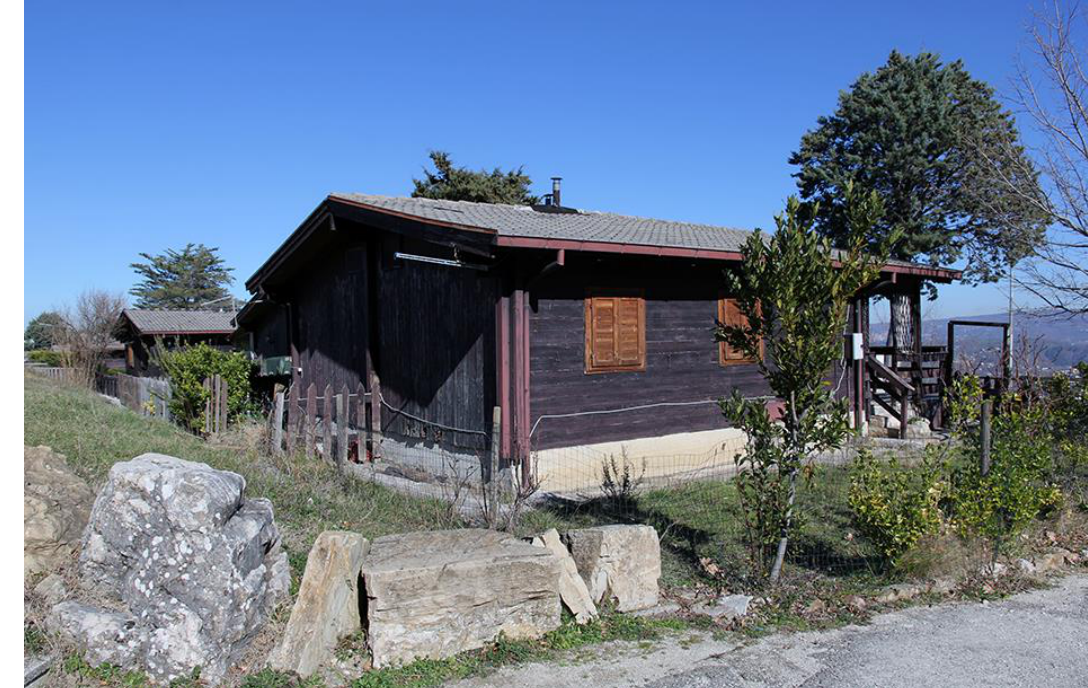
Figure 58. San Mango sul Calore: “Villaggio S. Stefano”. Temporary village, consisting of wooden chalets, built immediately after the 1980 earthquake (photos by [35,36]).